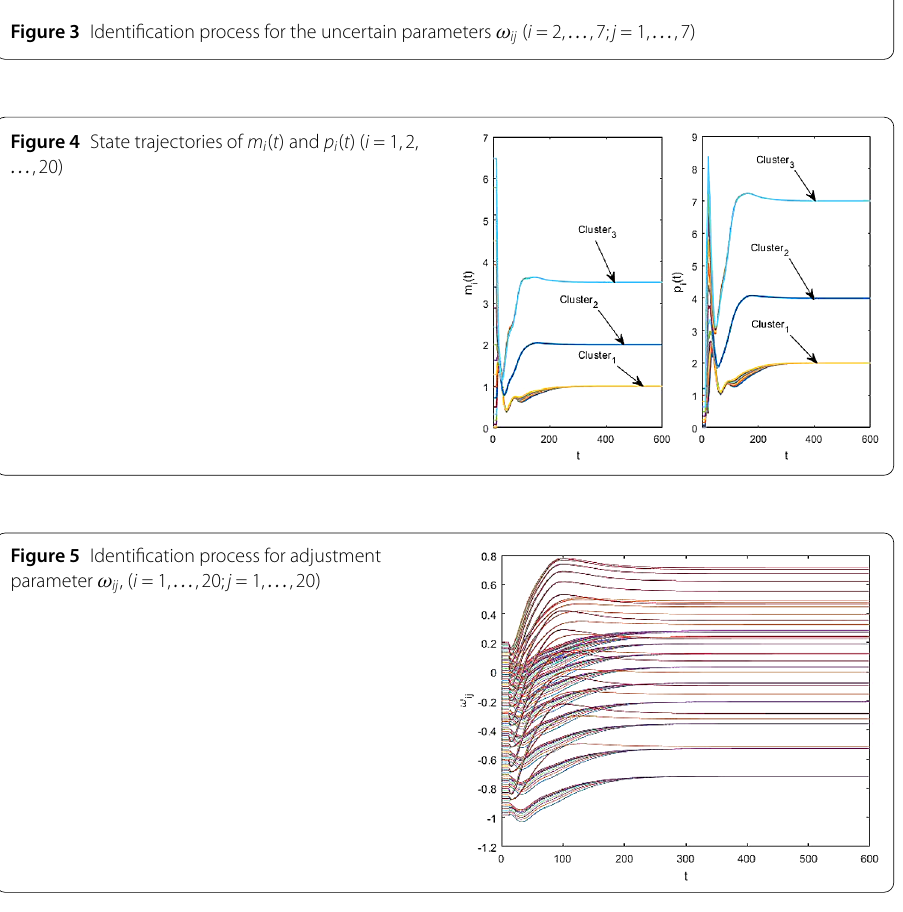
p i ( i = 1,...,10) belong to the first cluster, the concentrations of m i and p i ( i = 11,...,15) belong to the second cluster, and the concentrations of m i , p i ( i = 16,...,20) approach